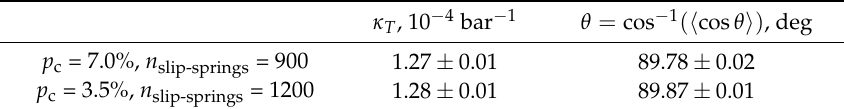
Figure 6. Real distances of nodal points along the chains (see also Equation (38)) as a function of the number of strands ( n strand ) for a crosslinked polymer network (this is the same crosslinked network of Figures 4 and 5). Table 2. Isothermal compressibilities and θ angles for polymer networks simulated in the context of this study.